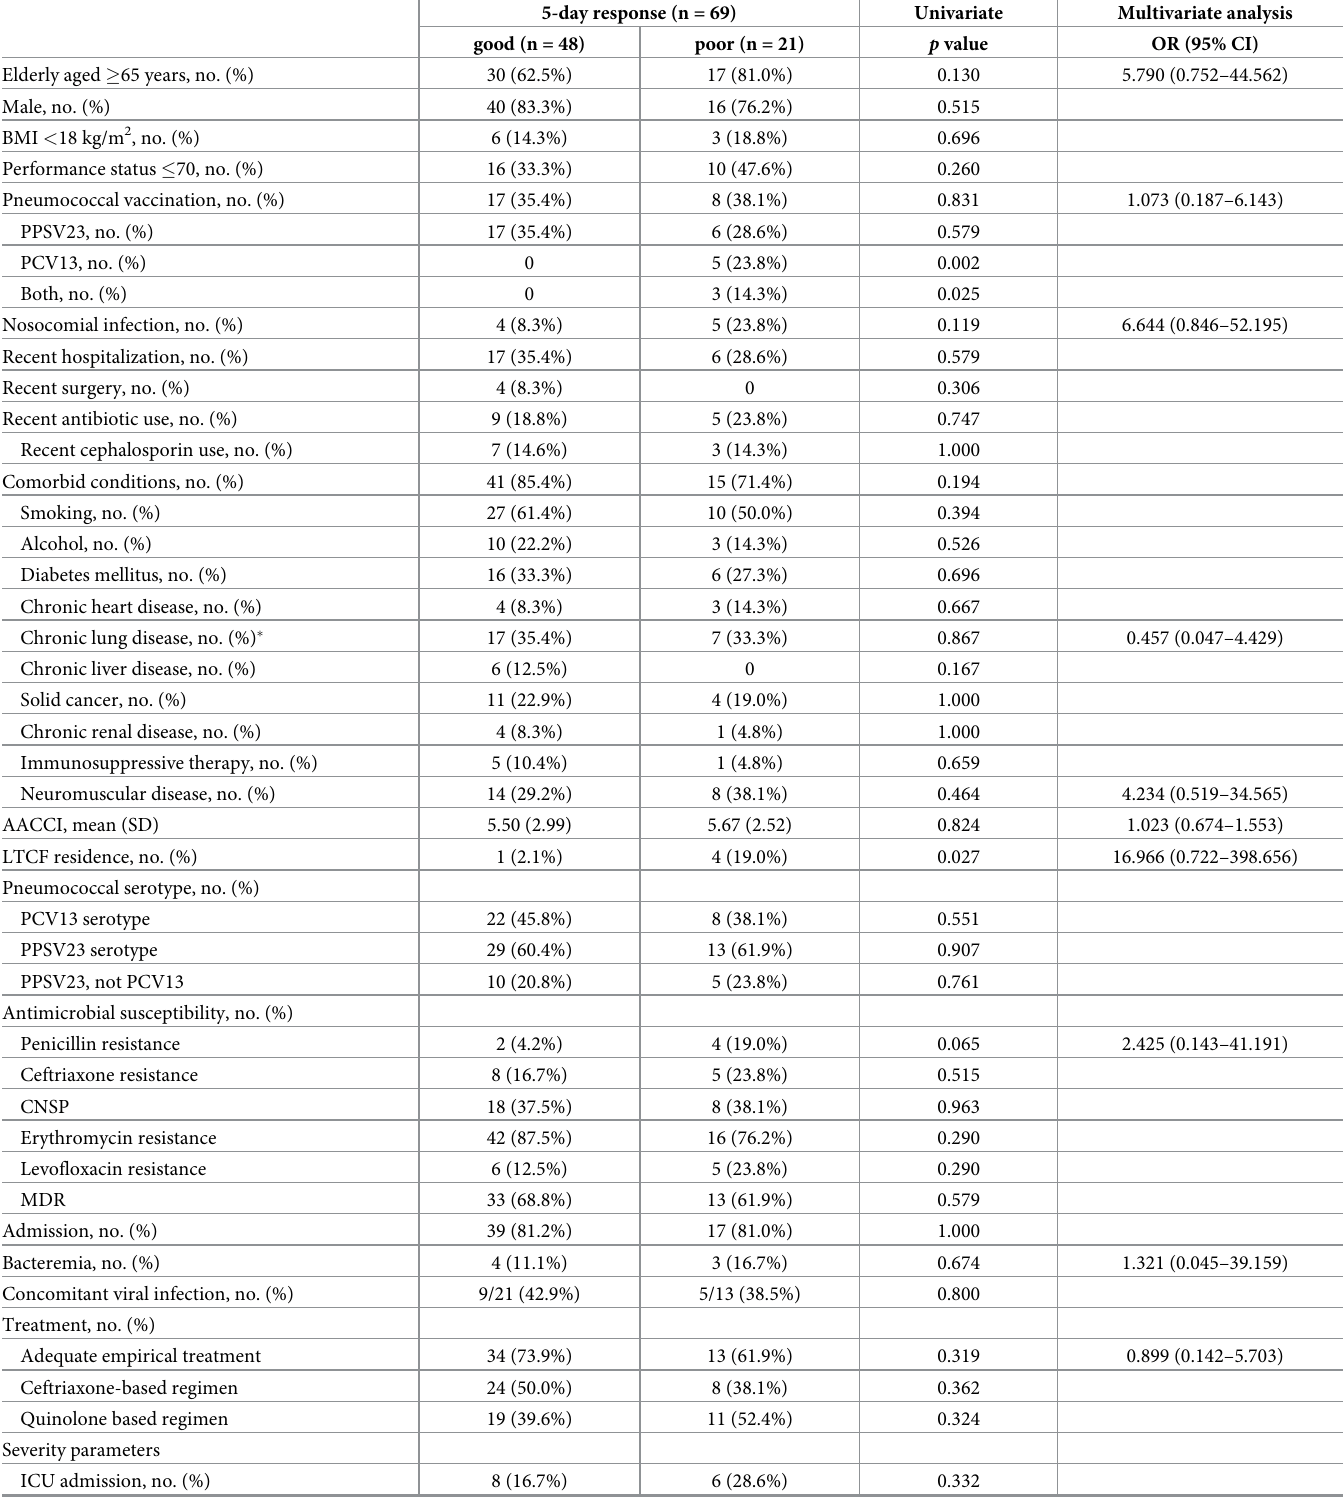
Table 3. Factors associated with 5-day treatment response among cases with true pneumococcal